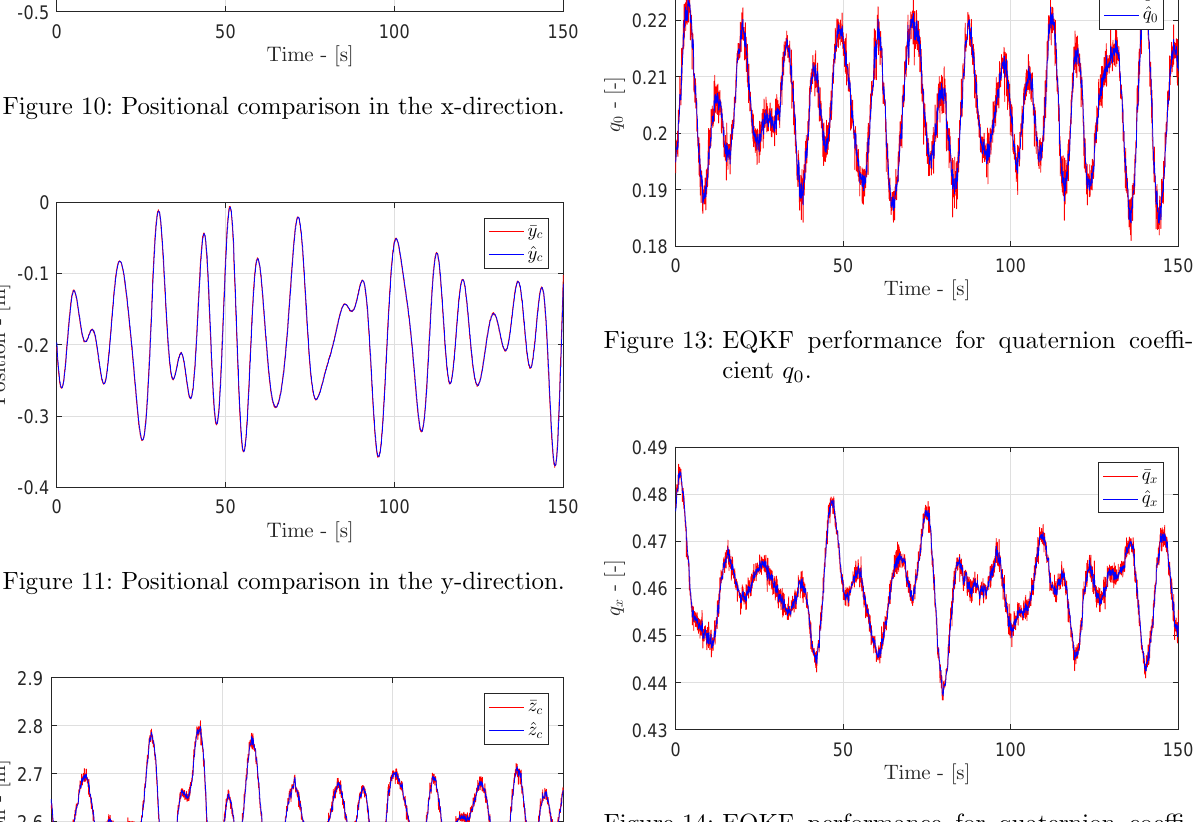
Figure 14: EQKF performance for quaternion coeffi- cient q x .